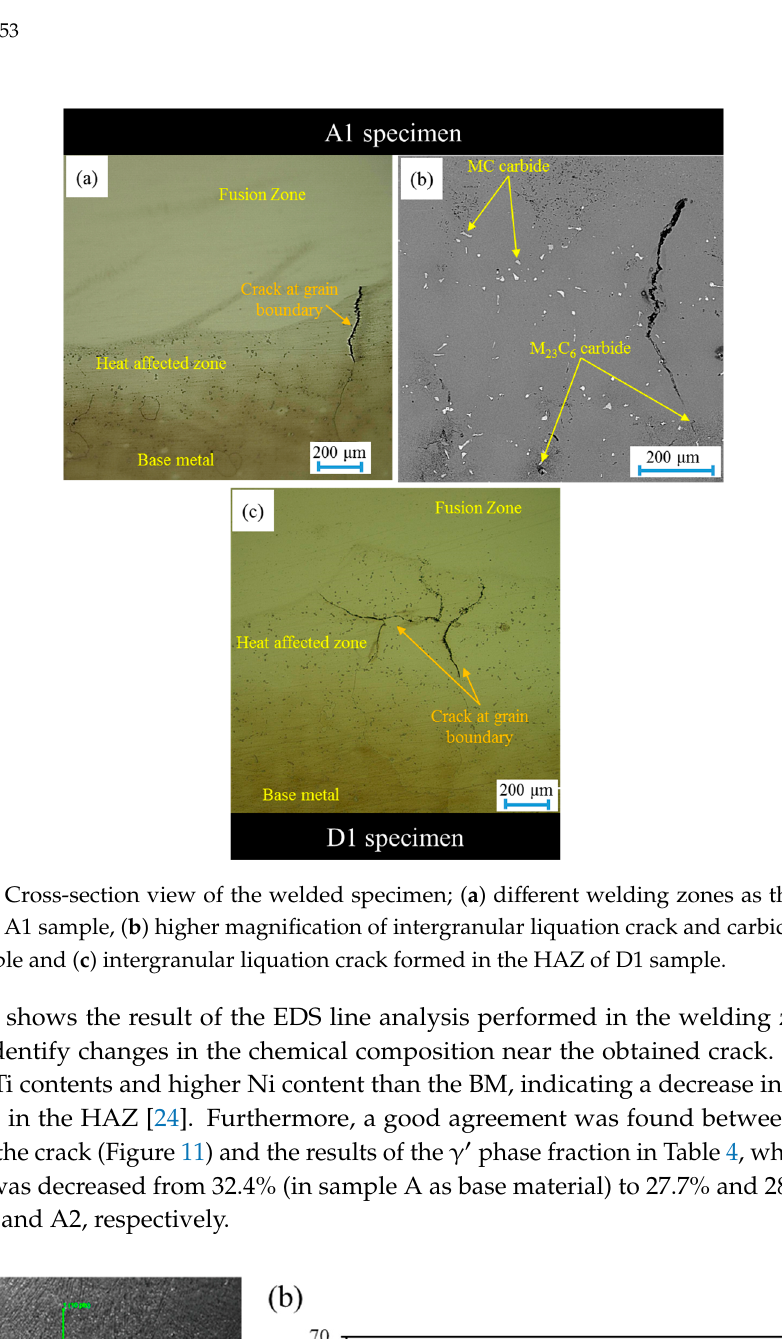
Figure 10. Cross-section view of the welded specimen; ( a ) different welding zones as the result of welding in A1 sample, ( b ) higher magnification of intergranular liquation crack and carbides in HAZ of A1 sample and ( c ) intergranular liquation crack formed in the HAZ of D1 sample.